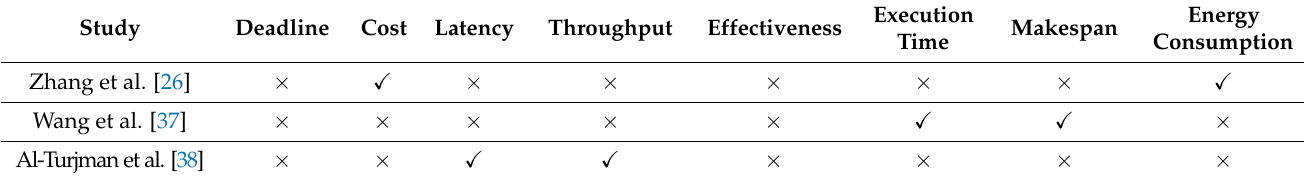
Table 15. Analysis of articles in terms of evaluation parameters in shopping system